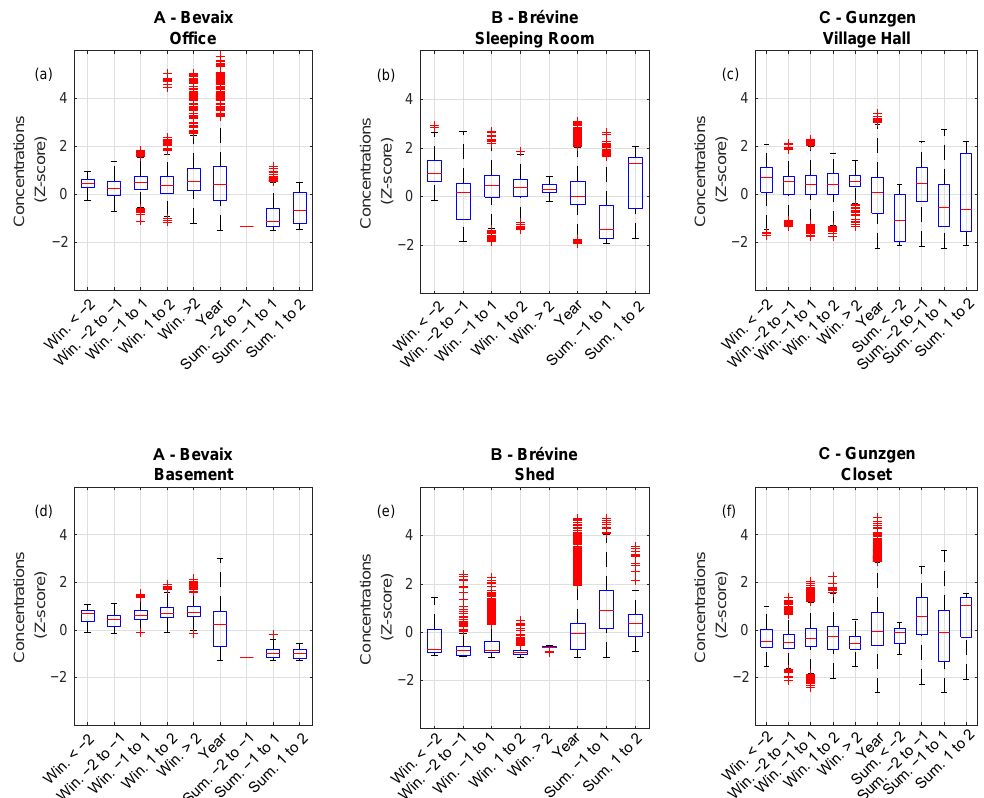
Figure 3. Box-plots synthesizing the impacts of atmospheric pressure on IRC at Bevaix ( a , d ), La Brévine ( b , e ), and Gunzgen ( c , f ). Occupied spaces are shown in ( a – c ) and unoccupied spaces in ( d – f ). Annual standard deviation threshold results are given for both winter and summer. Some of them are missing for summer because they did not